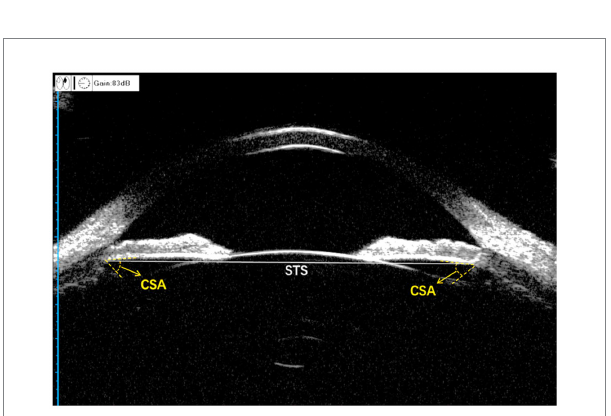
FIGURE 2 Measurement of the anterior segment parameters with UBM. CSA, ciliary sulcus angle; STS, sulcus-to-sulcus. The gray solid line is STS and the angle formed by the two yellow dashed lines is